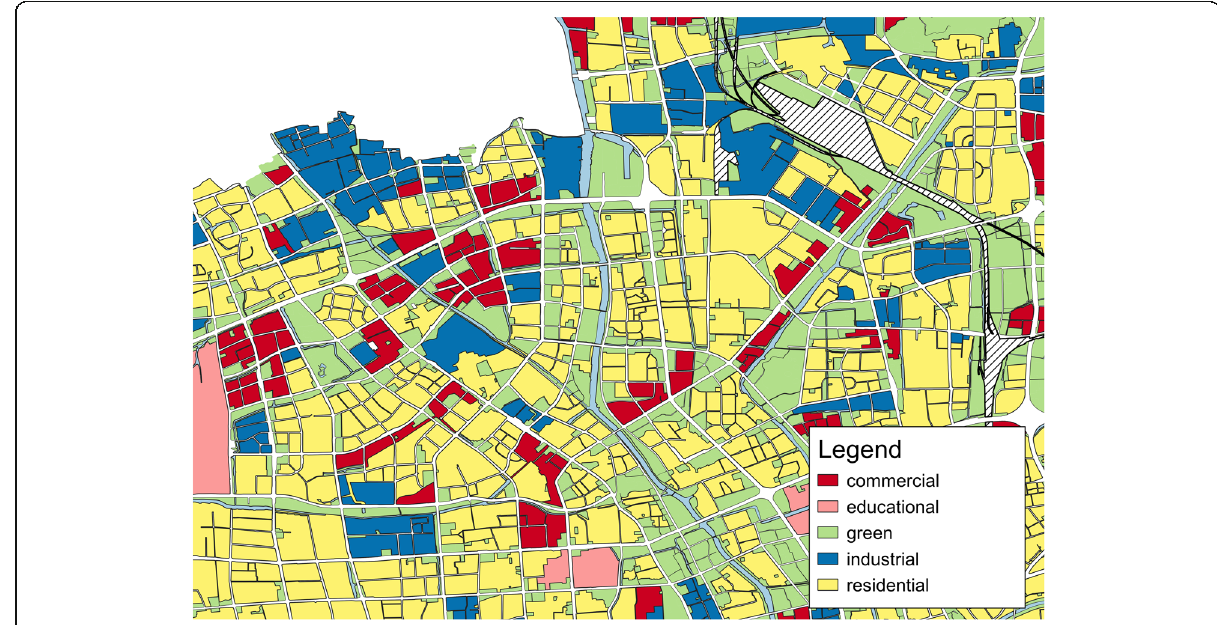
Fig. 4 Urban Planning Map for Hangzhou